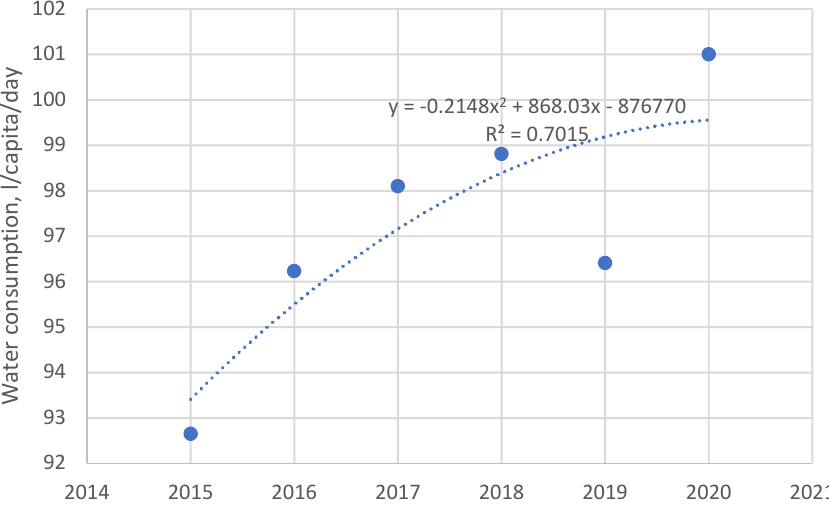
Figure 1. Water consumption (liter per capita per day) during 2011–2020.